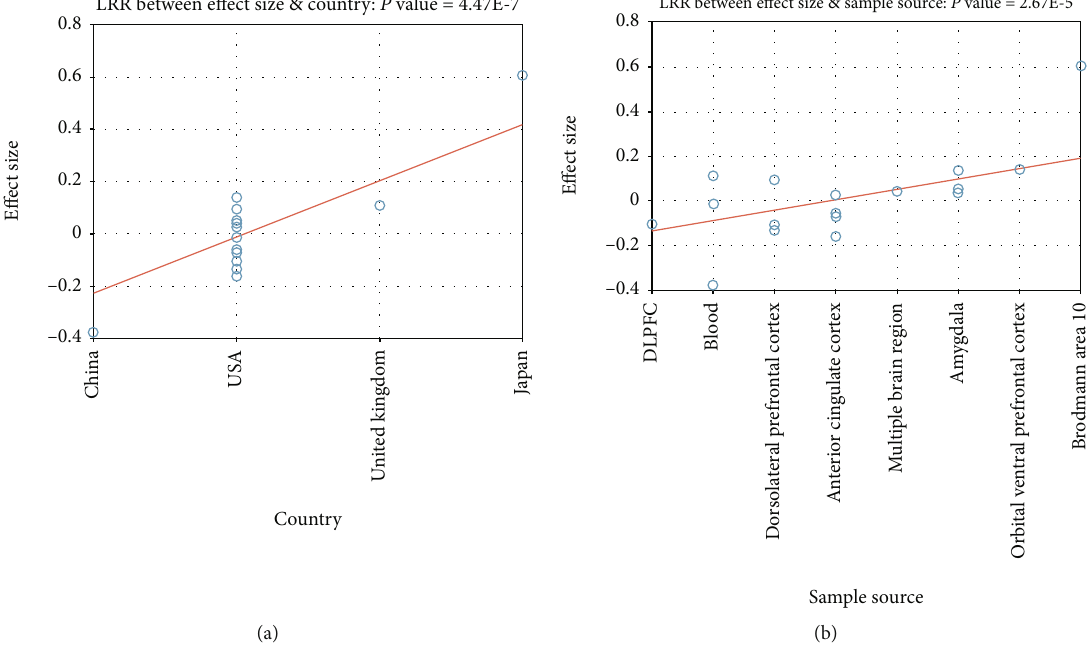
Figure 3: Multiple linear regression analysis results for the in fl uential factors of PPARD expression in the cases of major depressive disorder: (a) results for population regions (country); (b) results for sample